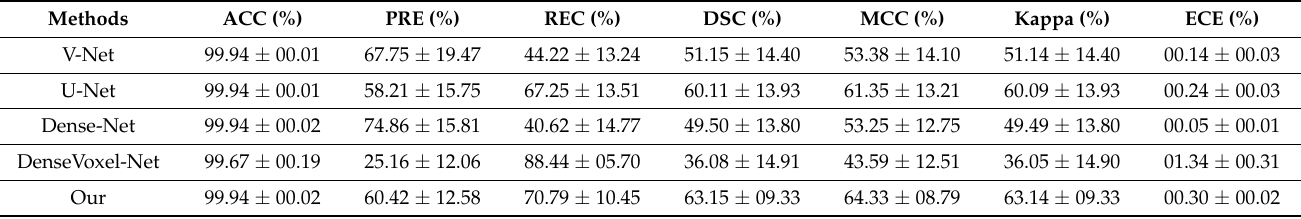
Table 7. Comparison of the segmentation with different methods on private dataset (compared with the manual ground truth).